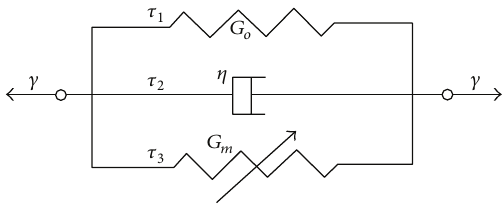
Figure 4: The viscoelastic model of MRE.